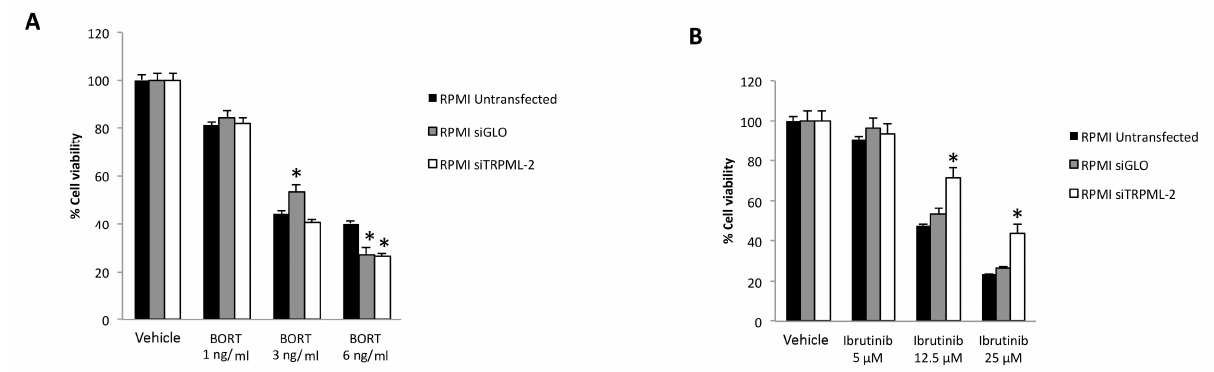
Figure 8. Cell viability assay in untransfected, siGLO and siTRPML2 RPMI cells treated for 48 h with Bortezomib (BORT) ( A ) or Ibrutinib ( B ). Data are the mean ± SD of three different experiments. * p < 0.05 vs. untreated cells.